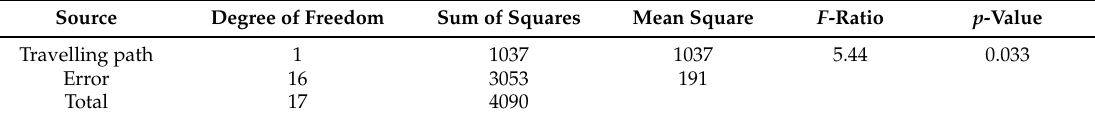
Table 16. ANOVA table of the tensile strength for experiment #3-2 (6.6-kW disk laser welding system). Source Degree of Freedom